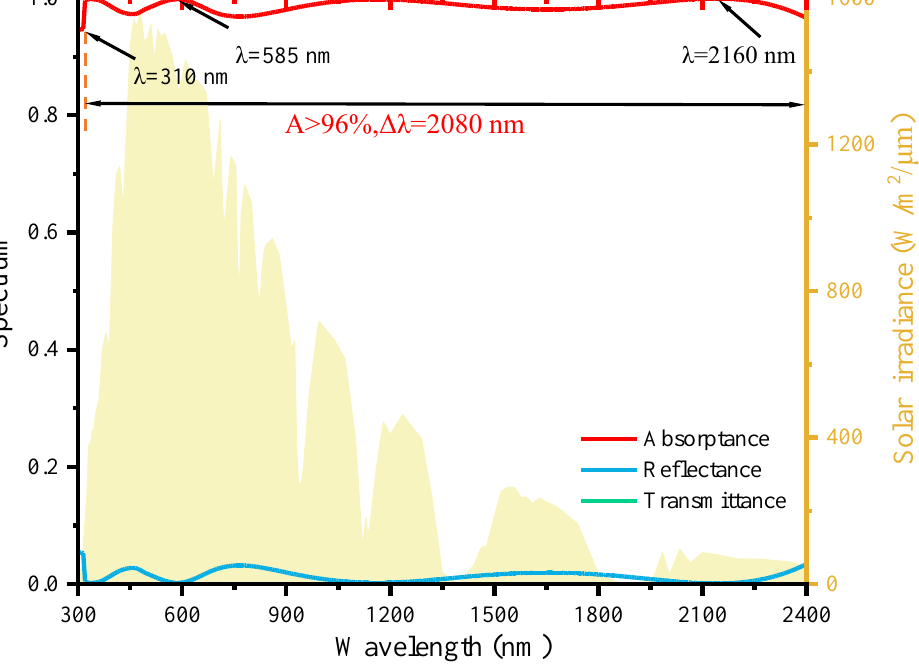
Figure 2. The absorption properties of the proposed absorber. The red, blue and green lines represent the absorptance, reflectance and transmittance of the absorber in the wavelength range of 300–2400 nm, respectively.